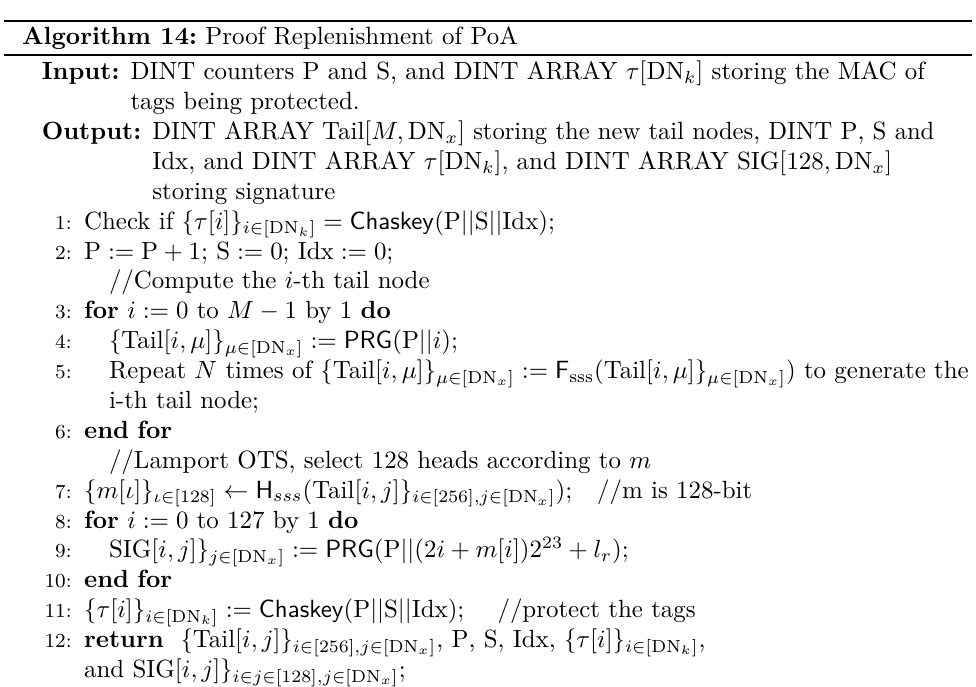
Algorithm 14: Proof Replenishment of